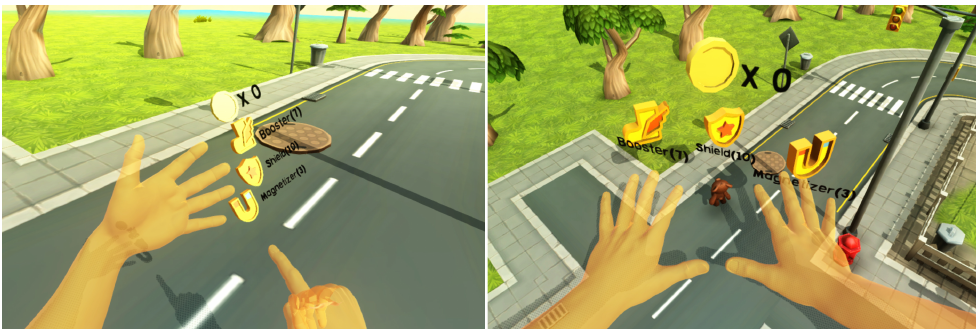
Figure 3. Example of GUI configuration in virtual reality application using images or objects in 3D space [33].